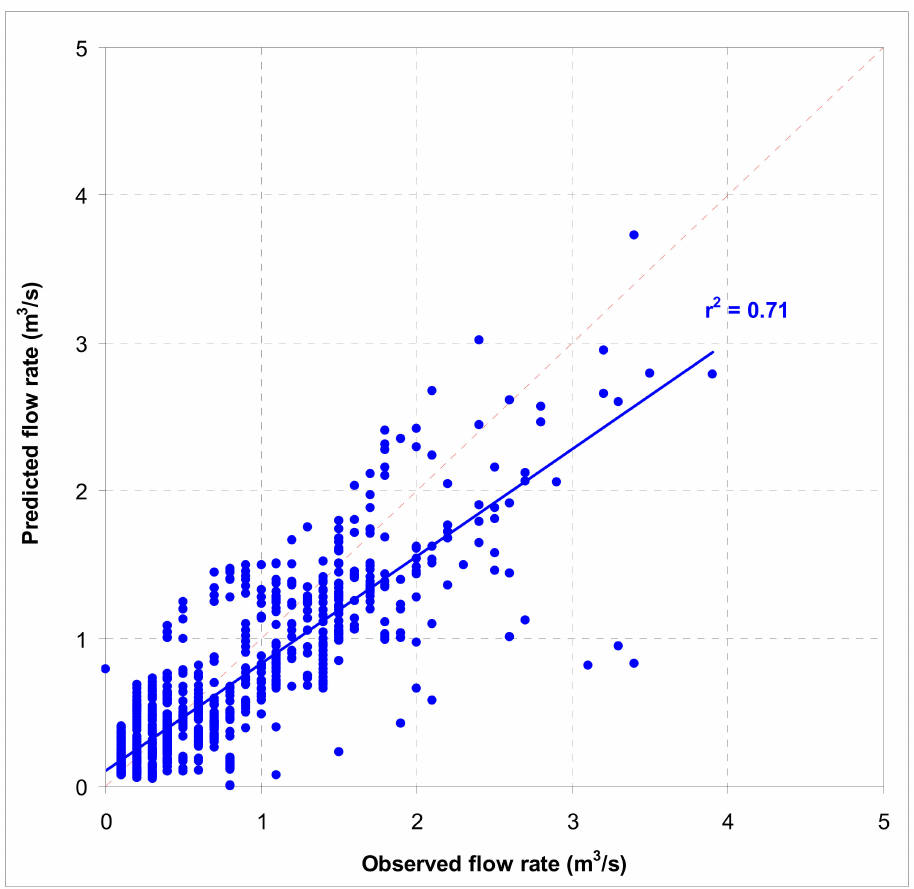
Figure 5. Scatterplot of the observed vs. simulated flow events in the Duverso torrent (Calabria, Southern